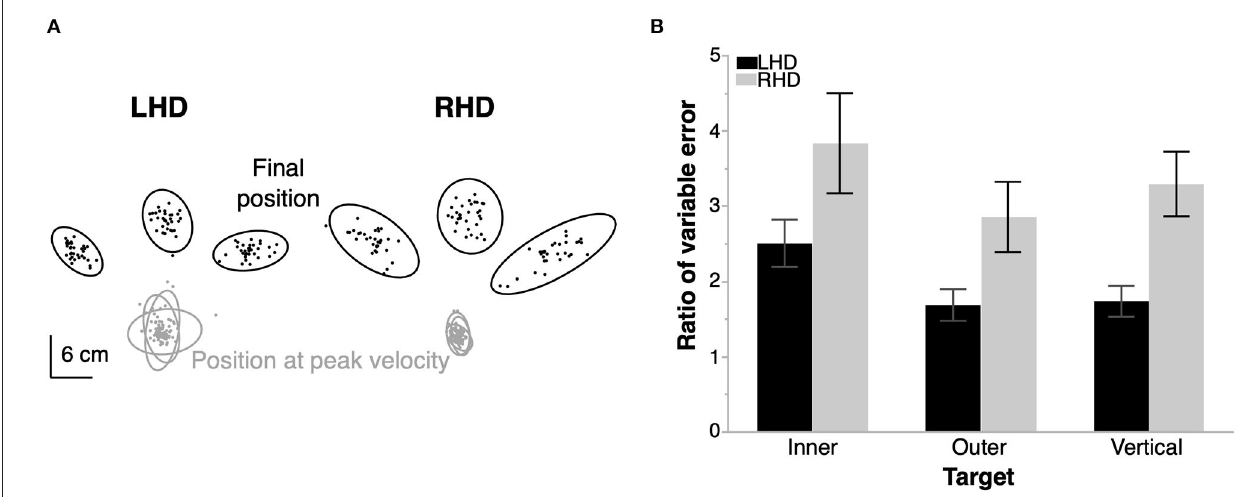
FIGURE 3 | Ipsilesional arm reaching task. (A) Location of the hand at peak velocity and at the end of movement for each trial in a representative left- (LHD) and right- (RHD) hemisphere damaged individual. Ellipses represent the 99% confidence interval of the data from each target for each individual. (B) Mean ratio of variable error at end of movement relative to that at peak velocity for each target in a group. RHD produces a statistically significantly higher ratio of variable error than LHD. Error bars represent 1s.e.m. across participants in each group (10 LHD, 10